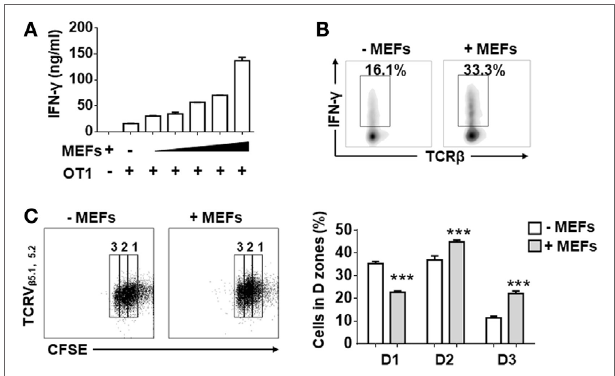
FigUre 1 | Mouse embryonic fibroblasts (MEFs) promote activation of CD8 + T cells activation. (a) Sorted CD8 + T cells from OT-1 splenocytes were activated by K b -OVA beads in the presence of different numbers of B6 MEF feeders [0, 0.3, 0.6, 1.3, 2.5, 5 × 10 4 /well (96 well, 200 µl culture medium)]. After 3 days of TCR stimulation, the level of interferon-gamma (IFN- γ ) production was detected by ELISA. (B) On day 3, flow cytometry analysis